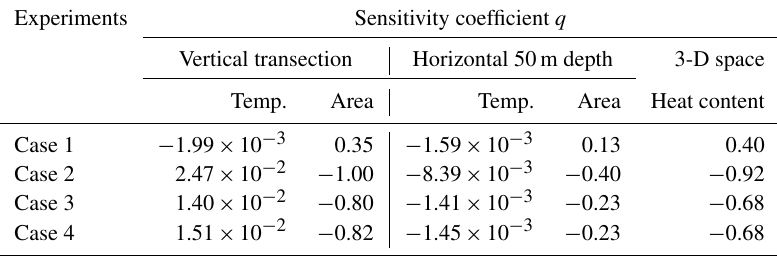
Table 2. Sensitivity coefficient of INCWM characteristics in four sensitivity numerical experiments.